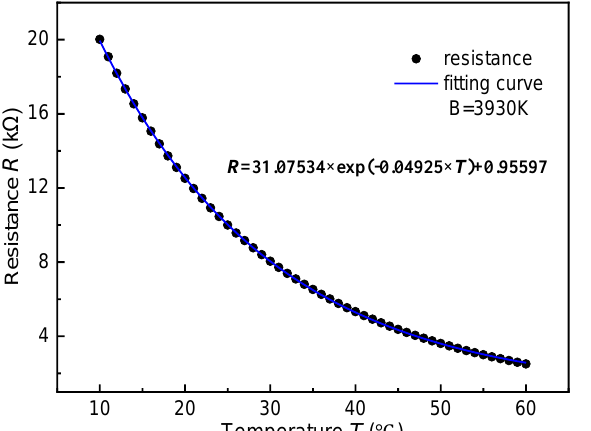
Figure 3. The relationship between the resistance and laser temperature is obtained by using the R-T conversion table of the thermistor inside laser.